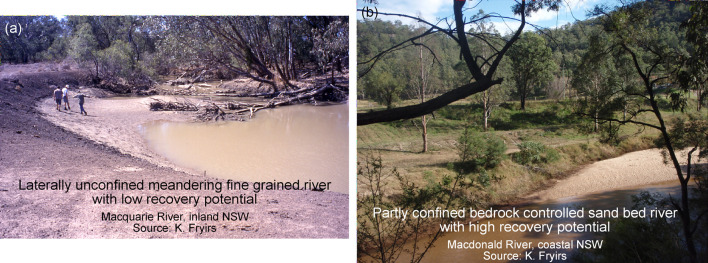
Fine-grained river in inland NSW and sand bed river in coastal NSW.Source of photos; K. Fryirs as noted.